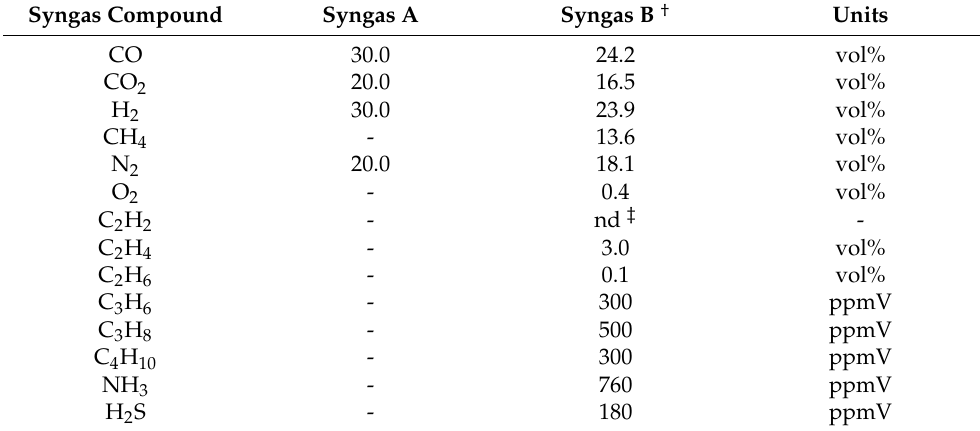
Table 1. Composition of the syngas used for bioconversion by B. methylotrophicum . Syngas A was the synthetic syngas formulation and Syngas B was obtained from the gasification of technical